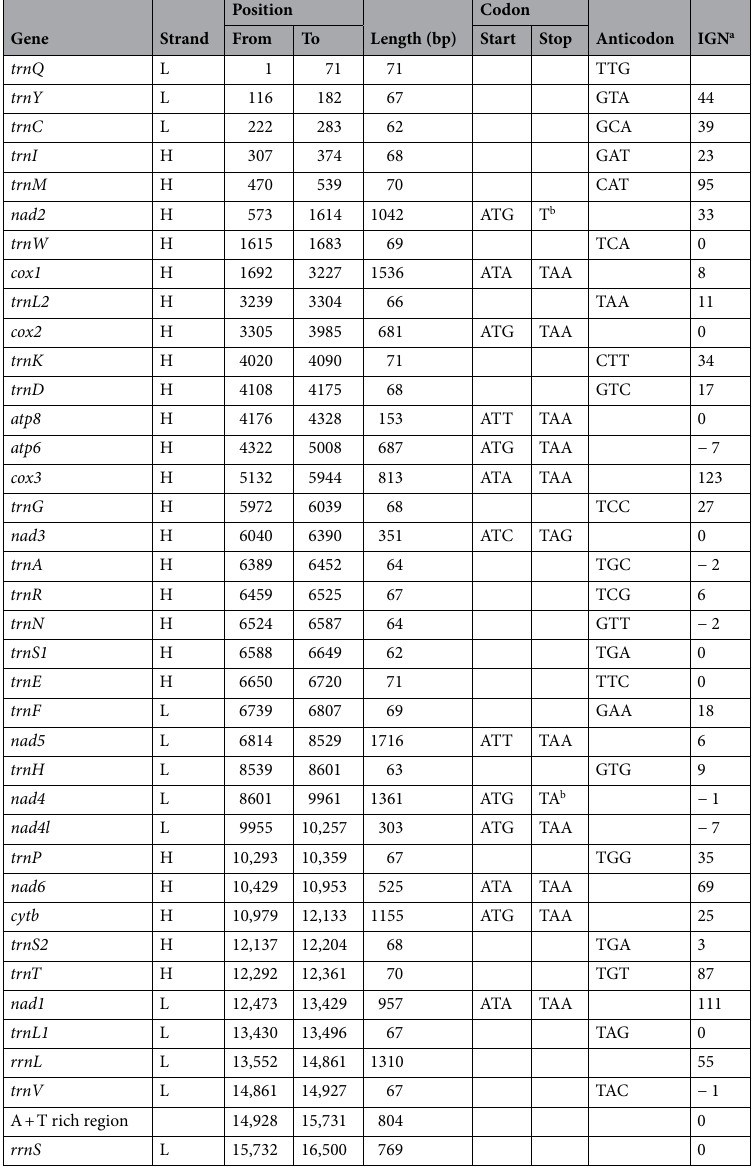
Table 1. Summary of the mtgenome characteristics of Euxiphydria potanini . a IGN refers to the number of intergenic nucleotides. b Incomplete termination codon that is probably extended by posttranscriptional